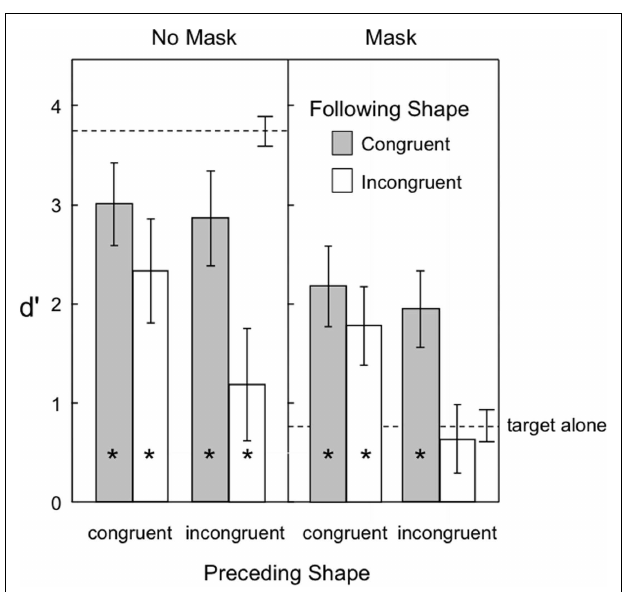
FIGURE 3 | Illustration of the displays in Experiment 2. Gray arrows indicate the two possible motion directions on the right side of the screen; equivalent paths were possible on the left side (not shown).